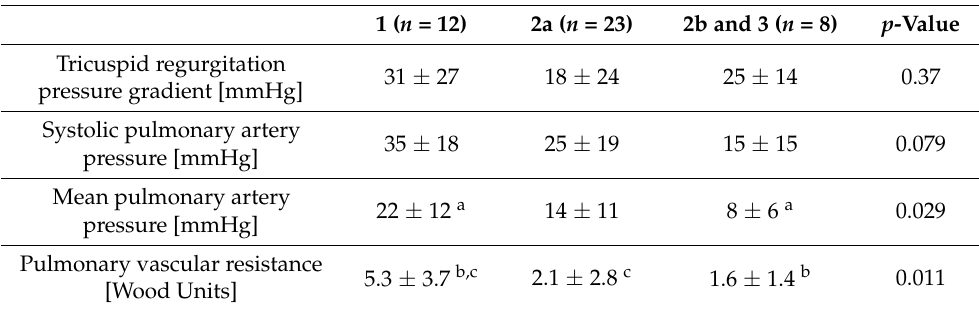
Table 4. Changes in hemodynamic parameters between preoperative baseline measurements and postoperative 3-months (six-minute walking test and echocardiography) or 12-months (right heart catheterization)